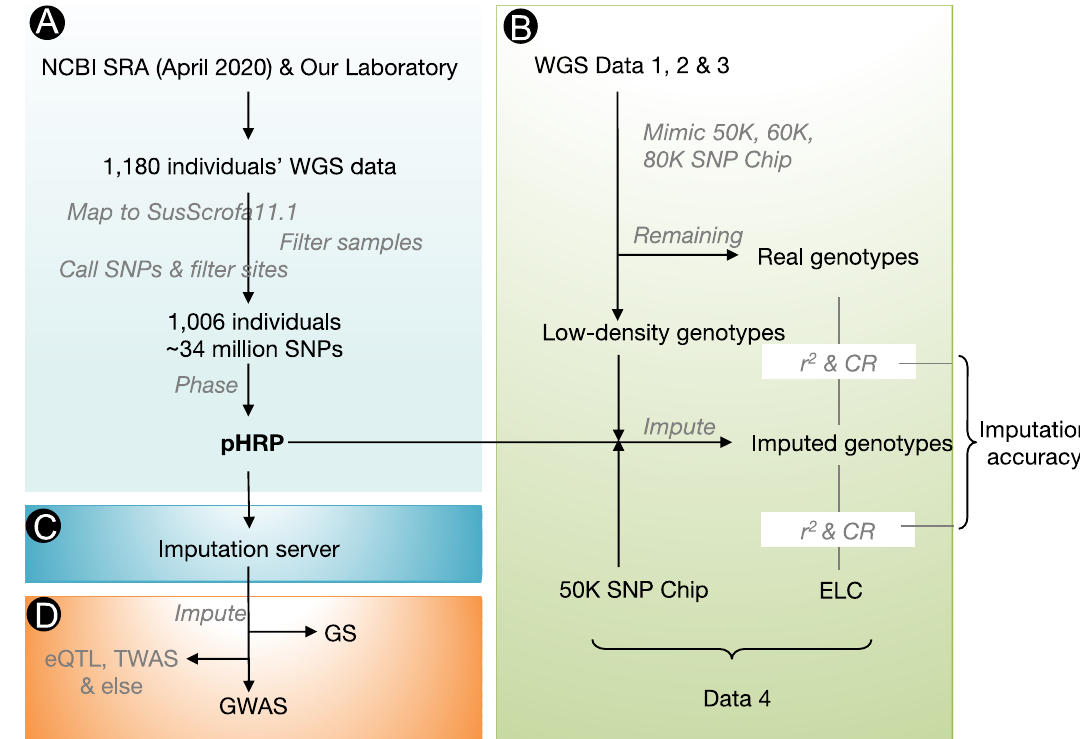
Figure 1. Schematic diagram of the pig haplotype reference panel’s construction, imputation accuracy evaluation, implementation platform and applications. ( A ) Data resources and processing steps used to construct the PHARP. ( B ) Imputation accuracy estimation of PHARP on multiple test datasets. ( C ) Imputation platform development. ( D ) Applications of PHARP in GWASs, GS and other potential studies such as eQTL mapping and